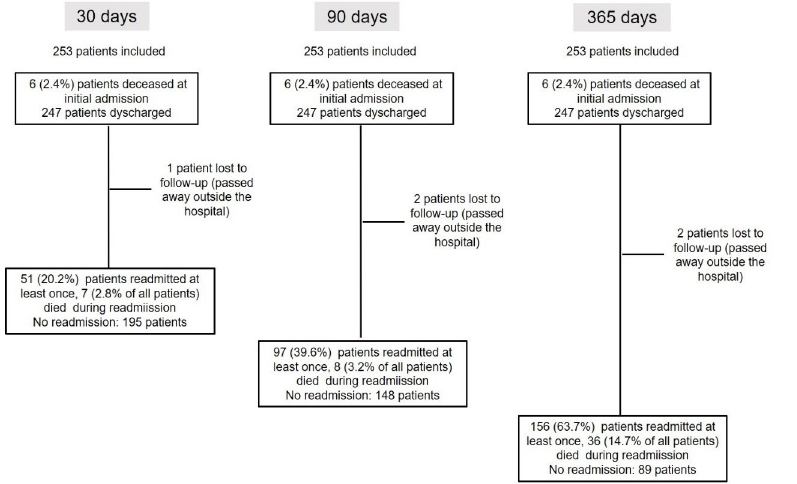
Fig 1. Flowchart showing the events that took place over the three study